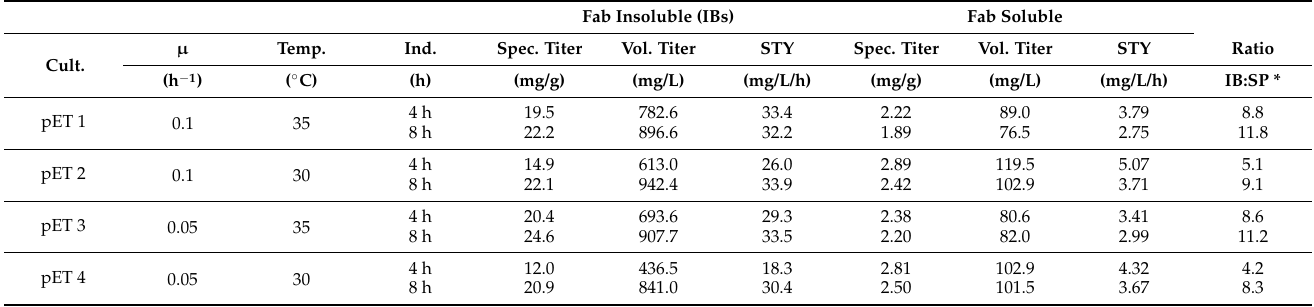
Table 2. Fab productivity for pET